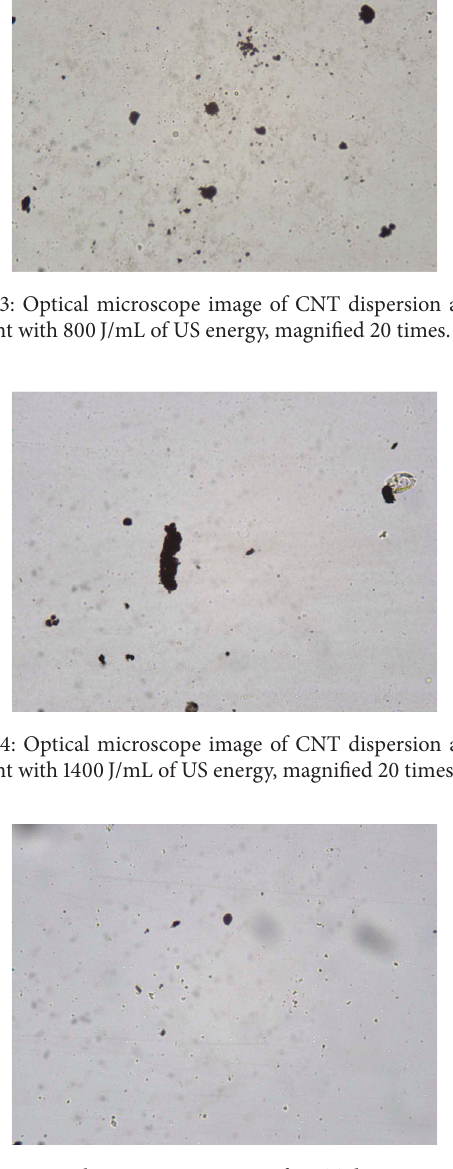
Figure 5: Optical microscope image of CNT dispersion after the treatment with 2000 J/mL of US energy, magnified 20 times.